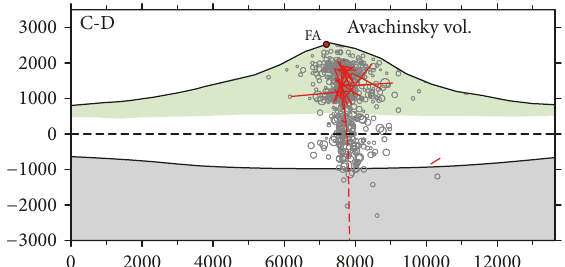
Figure 3: Geological cross-sectional CD (see Figure 1). Legend is the same as in Figure 2, and axes are labeled in meters.